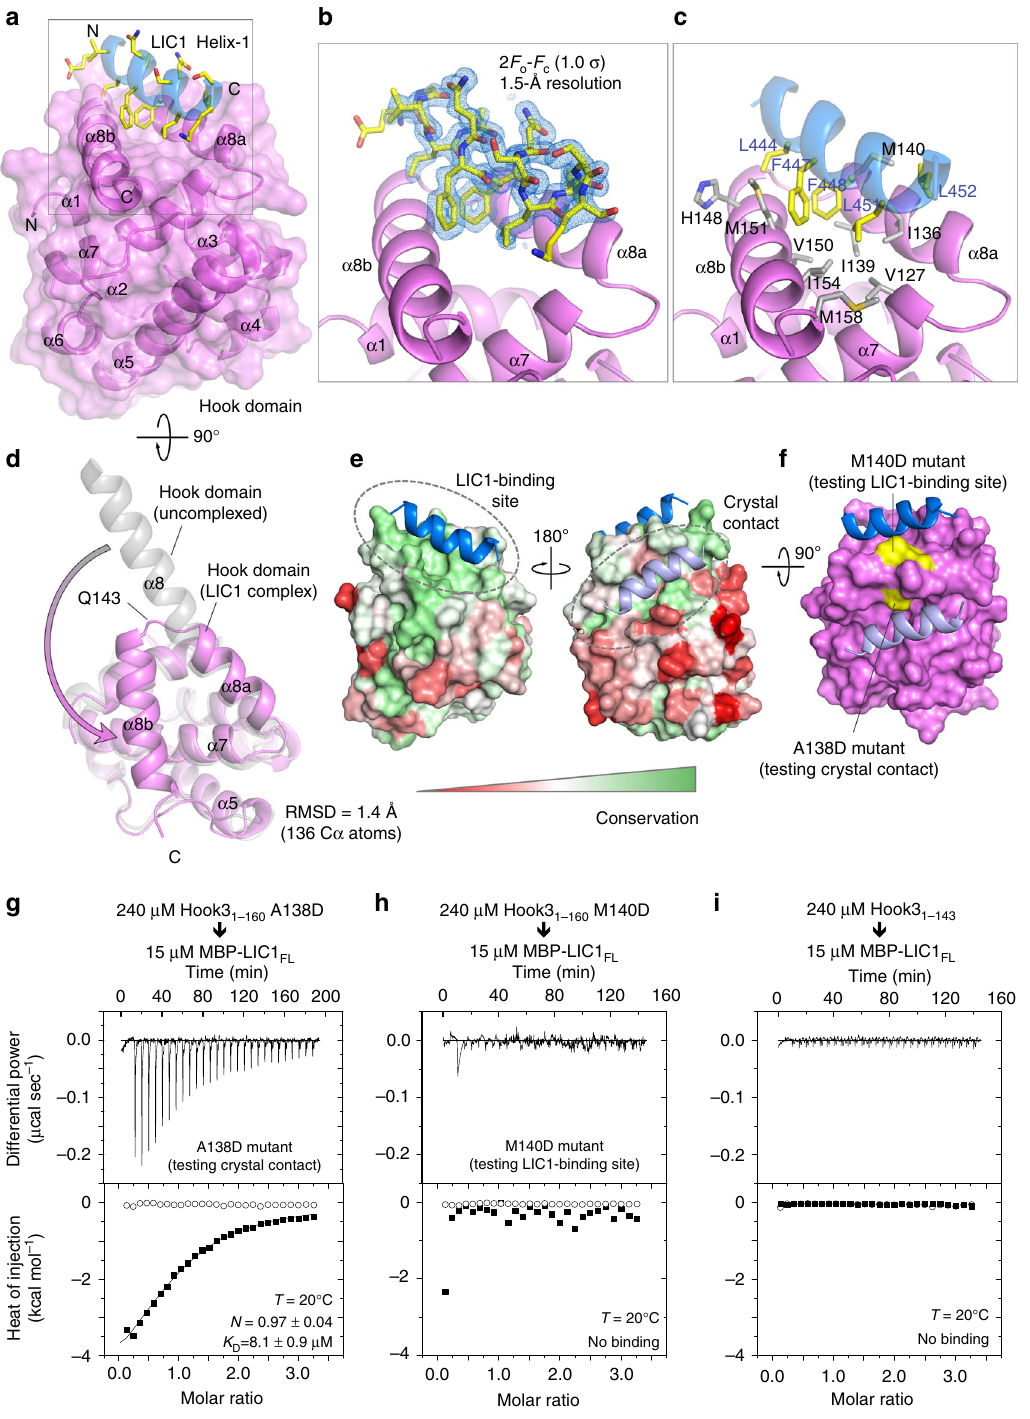
Fig. 3 Crystal structure of the Hook domain in complex with LIC1 Helix-1. a Ribbon and surface representation of the structure of Hook3 1 – 160 (magenta) in complex with Helix-1 (LIC1 433 – 458 , blue). The side chains of Helix-1 are shown using a sticks representation, colored by atom type. b Close-up view of the Helix-1 binding site, showing the 2 F o- F c electron density map (blue mesh) at 1.5 Å resolution, contoured at 1 σ around an all-atom representation of Helix-1. c Close-up view of the Helix-1 binding site, showing the residues at the hydrophobic contact interface. d Superimposition of the structure of the Hook domain from the Helix-1-bound complex (magenta) and unbound structure (gray) 9 . A conformational change in the C-terminal helix α 8, which distinguishes this domain from the CH domain, leads to the formation of two helices ( α 8a and α 8b) that constitute the binding site for Helix-1. e Sequence conservation of the Hook domain (see also Supplementary Fig. 1) mapped onto the surface of the structure and colored from low to high conservation using a red to green gradient. In the crystal lattice, the Hook domain contacts a second Helix-1 from a neighboring complex (light blue). f Surface representation of the Hook domain (magenta), showing in yellow the two amino acids mutated (A138D and M140D) to test the functional relevance of the two Helix-1 interactions. g – i ITC titrations of the indicated Hook3 1 – 160 mutants into MBP-LIC1 FL . Experimental conditions and fi tting parameters are listed. Errors correspond to the s.d. of the fi ts. Open symbols correspond to titrations into